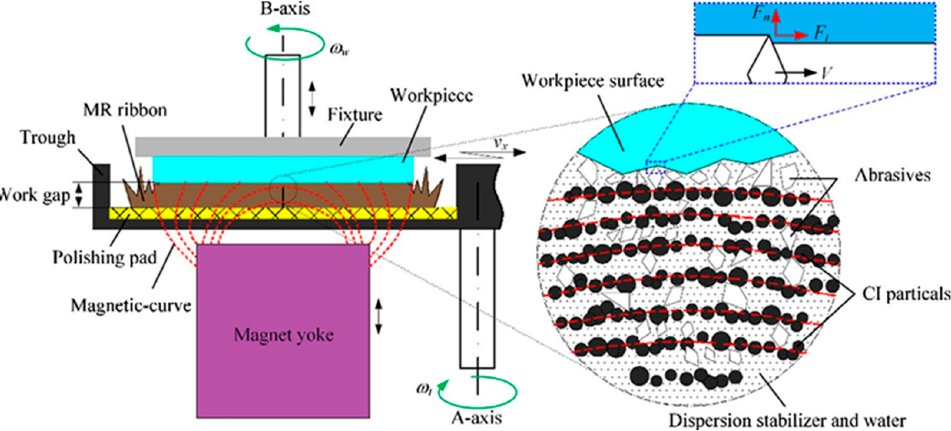
Figure 8. Schematic of magnetorheological finishing of ZrO 2 ceramics, reused with permission from Elsevier [61].